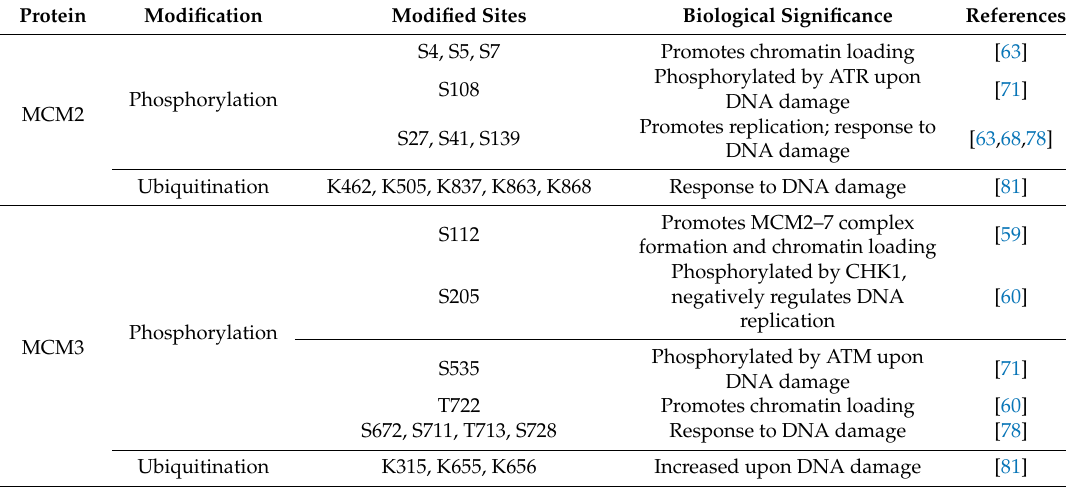
Table 8. Summary of functional modification sites for